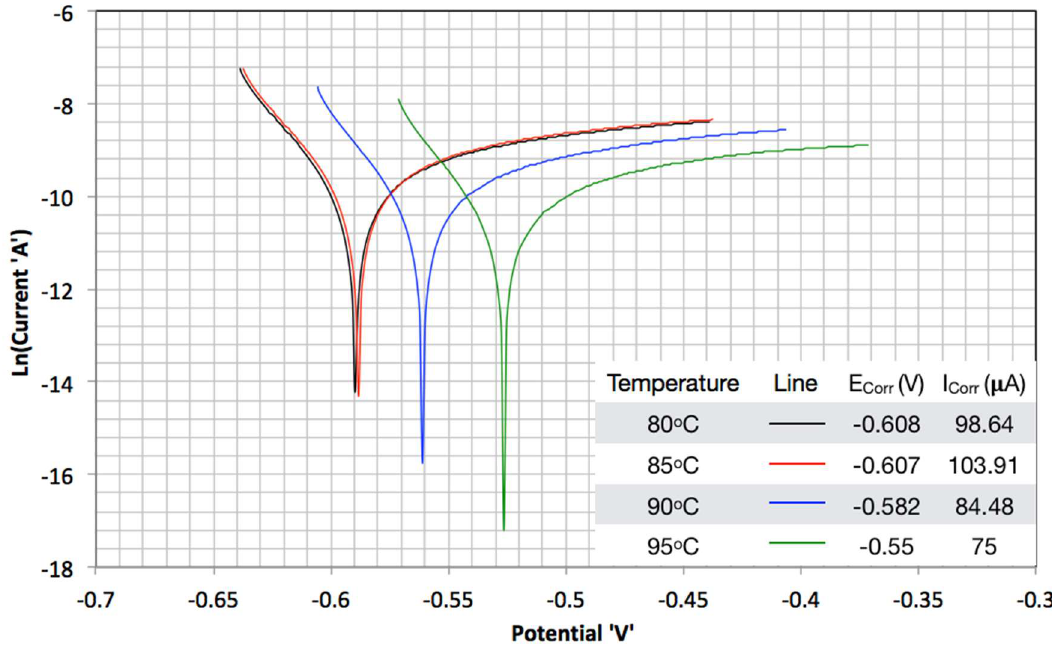
Figure 7. Tafel curves of [bmim][MS] and 20% MDEA with CO 2 at different temperatures. Scan rate = 1 mV/s. Fitted results for corrosion rates and potential are provided in the table.